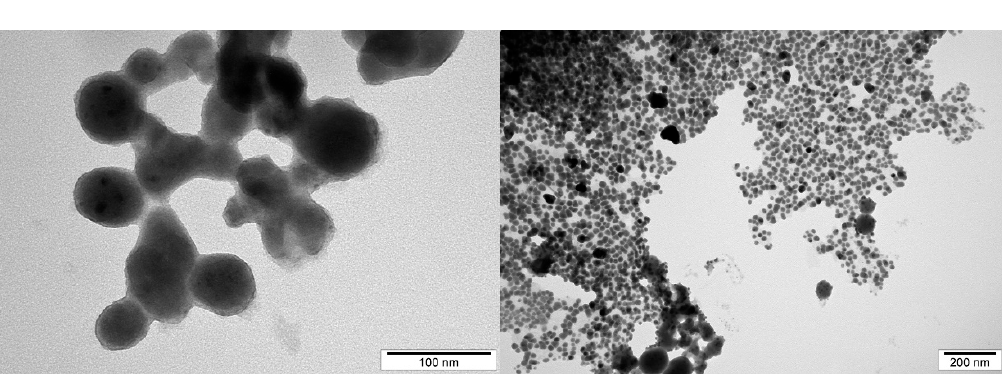
Figure 9. Transmission electron microscope photographs of AgNPs.